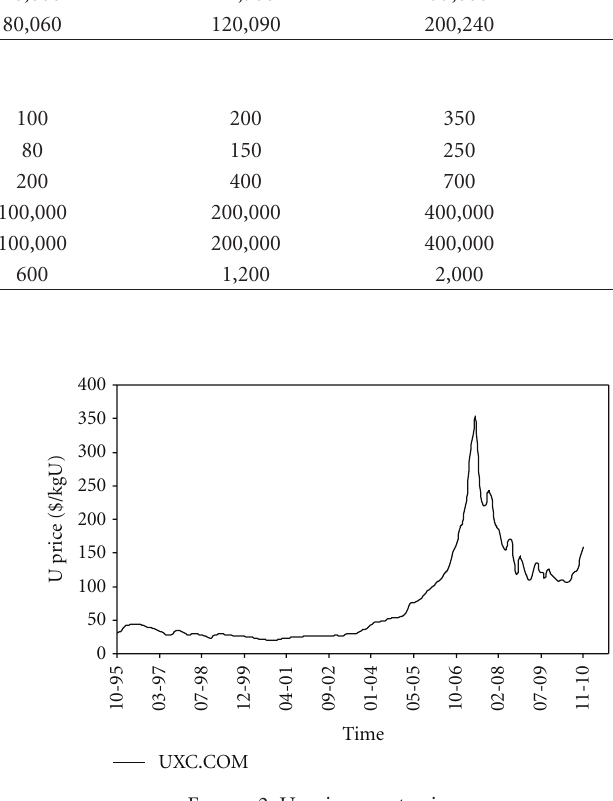
Figure 2: Uranium spot